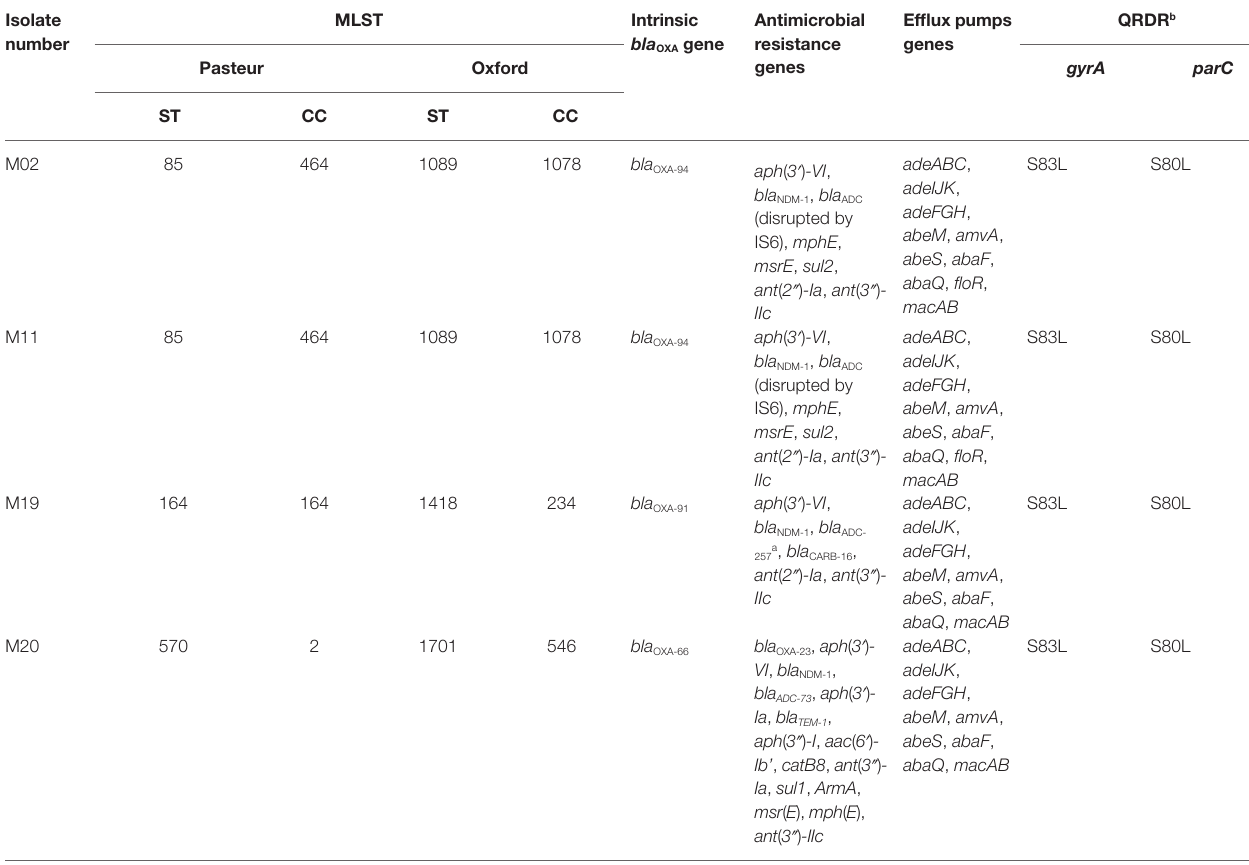
TABLE 2 | STs and antimicrobial resistance genes carried by the four bla NDM -positive isolates. Isolate